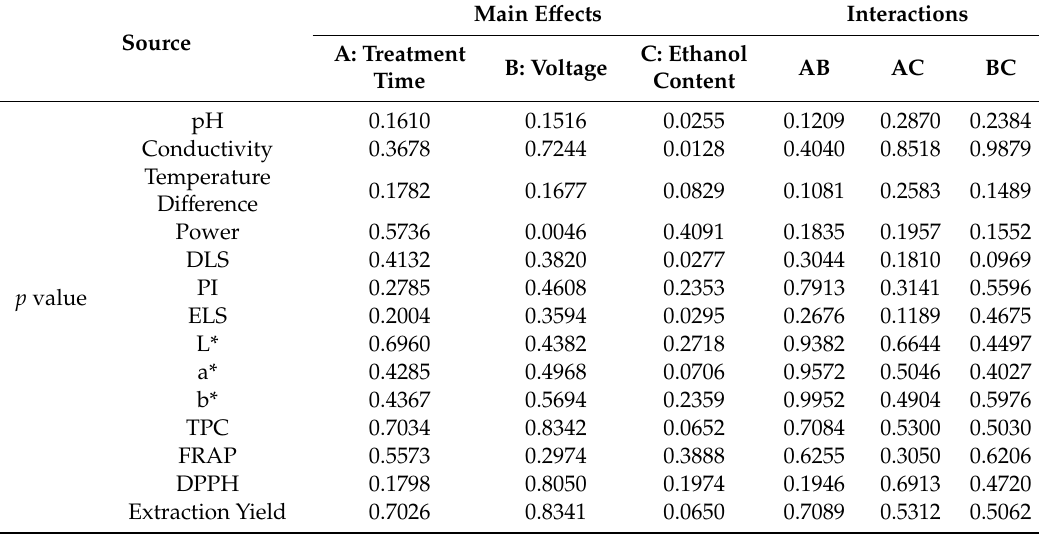
Table 8. Statistical significance for pH, conductivity, temperature di ff erence, power, DLS, PI, ELS, L*, a*, b*, TPC, FRAP, DPPH and yield of extraction. The MANOVA table decomposes the variability of each parameter into contributions due to various factors for OLs treated with